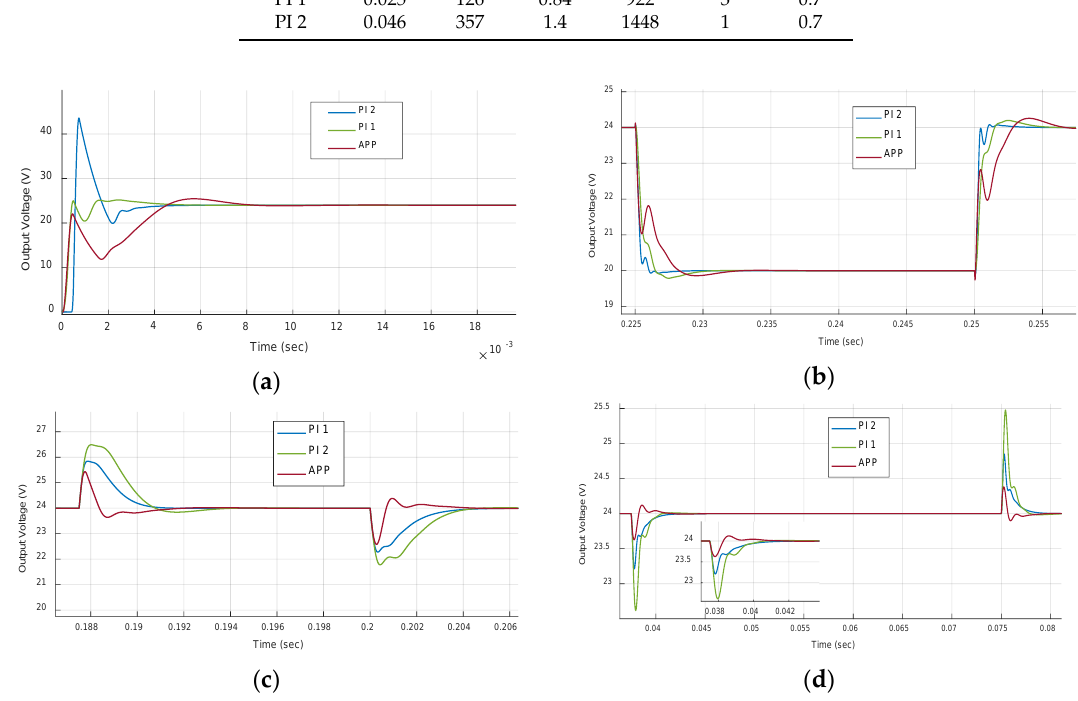
Figure 10. Comparative transient responses of the two PI designs of Table 3 with APP (PID + ROAPC). ( a ) Startup transient response for tracking a reference input of 24 V with an input voltage Vin = 12 V; ( b ) reference input changes from 24 V to 20 V and back; ( c ) rejection of load step changes (from 10 to 50 Ω and back); ( d ) dealing with step changes in the input voltage (from 12 to 10 V and back).